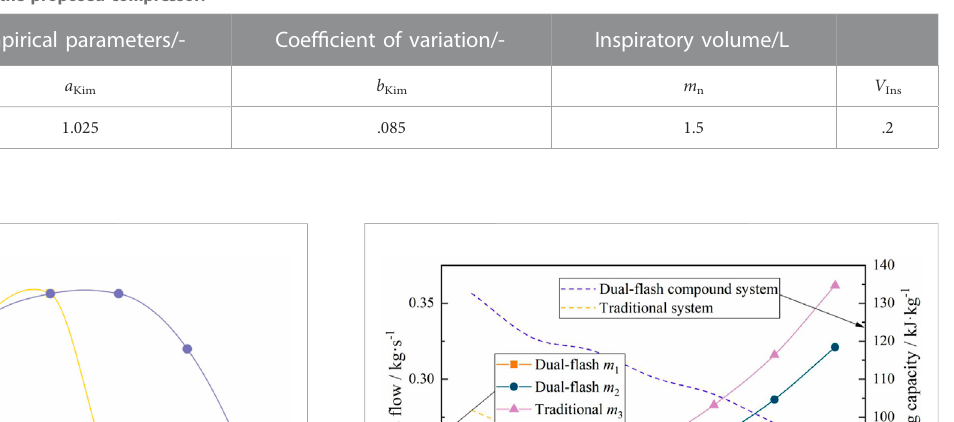
TABLE 4 Technical parameters of the proposed compressor.